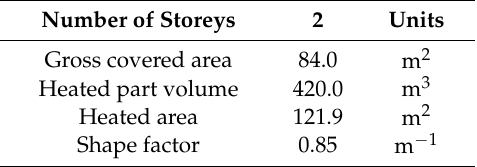
Table 9. Basic geometric data of the one-storey building with an